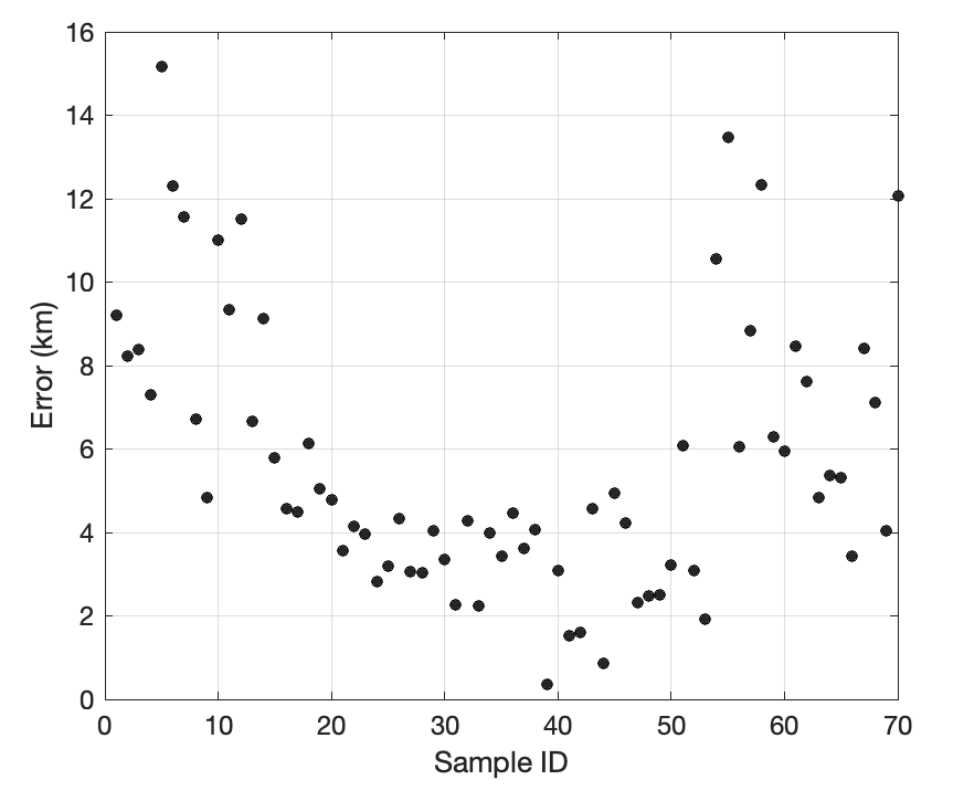
Figure 2. Error on the ground track determination through the COTS receiver data.